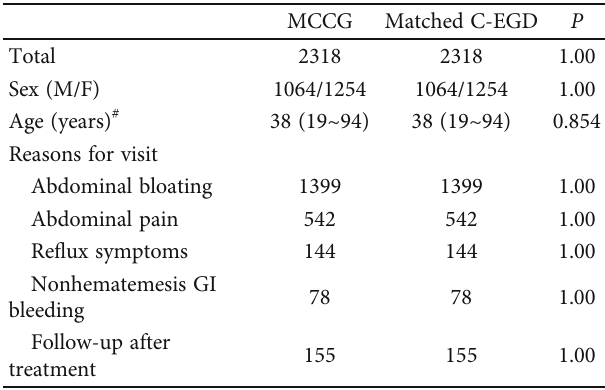
Table 1: Clinical characteristics.